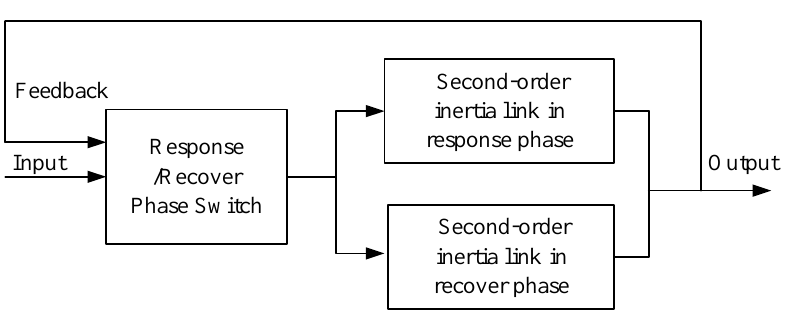
Figure 5. The MOS sensor